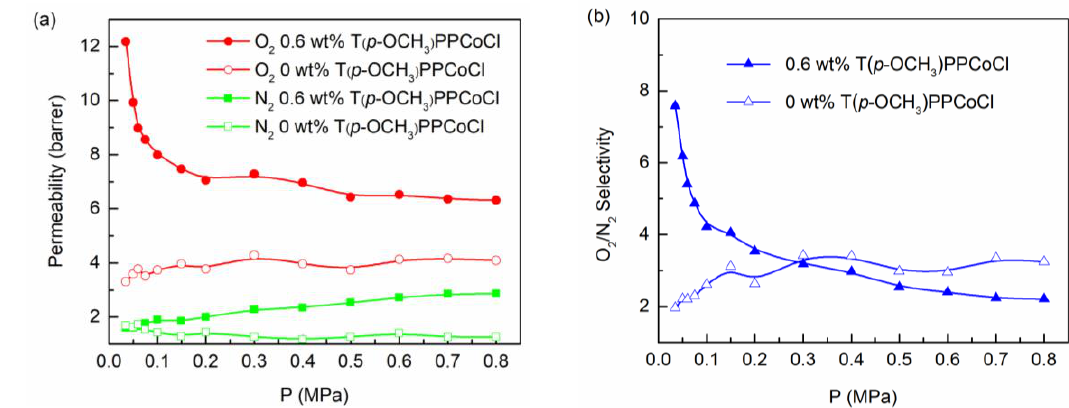
Figure 7. E ff ect of the feed pressure on gas permeability ( a ) and O 2 / N 2 selectivity ( b ). Figure 7. Effect of the feed pressure on gas permeability ( a ) and O Figure 7. Effect of the feed pressure on gas permeability ( a ) and O 2 /N 2 selectivity ( b ).